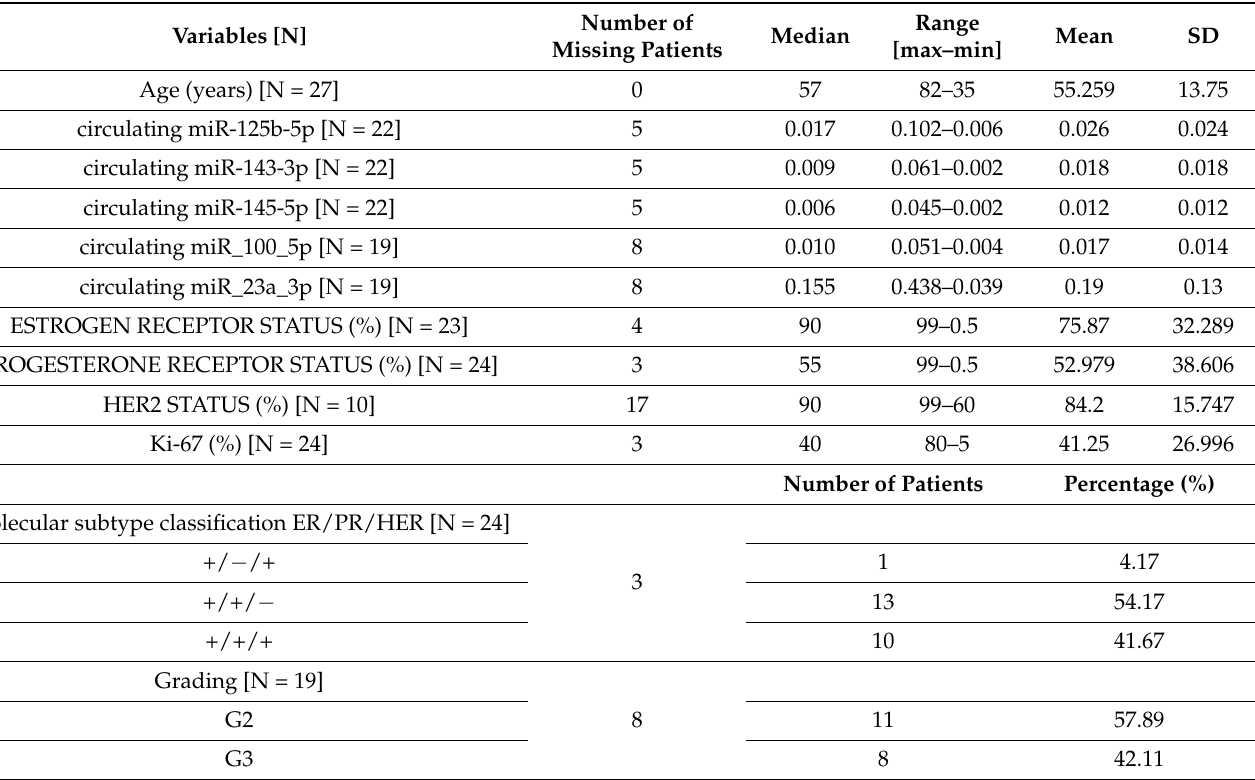
Table 1. Patient